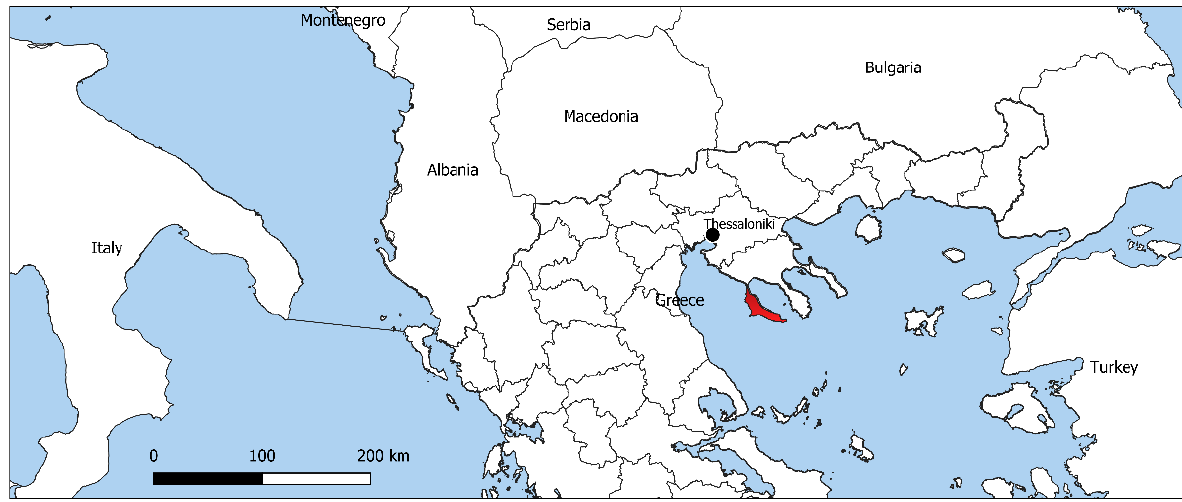
Figure 1. Location map of the study red area.